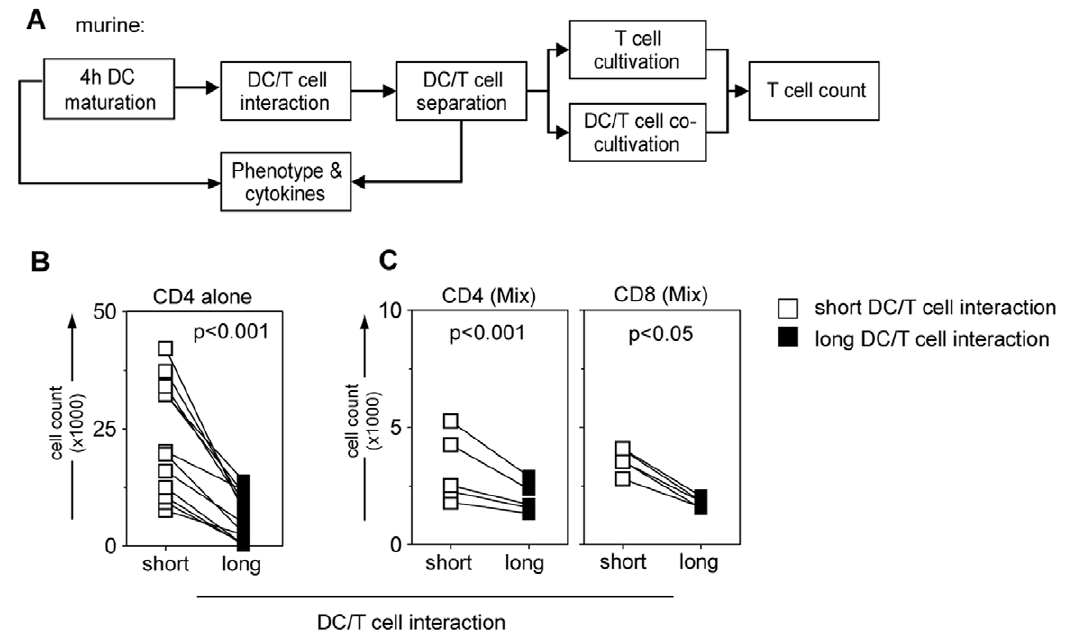
Figure 3. Proliferative capacity and polarization profile in short- versus long-term DC/T-cell co-cultures using murine BM-DC and T- cell receptor transgenic OT-I/II T-cells. (A) Murine BM-DCs were matured for 4 hours, contacted with naı¨ve syngeneic CD4 + enriched OT-II T-cells for 12 hours, separated using flow sorting, and either maintained alone in culture or re-cultivated with BM-DCs (further-on referred to as ‘‘short’’-term or ‘‘long’’-term DC/T-cell interaction, respectively), both for 3 days. (B) Total cell count of murine enriched CD4 + OT-II T-cells after 3 days DC/T-cell co- culture under short-term (white squares) or long-term (black squares) conditions with 4 hours LPS/IFN- c matured BM-DCs is shown. Pooled data from 12 experiments are shown as median 6 SEM. (C) A mixture of CD8 + OT-I and CD4 + OT-II T-cells was used (OT-I:OT-II=1:4) for short-term (white squares) or long-term (black squares) DC/T-cell co-culture, but analyzed on day 3 separately using specific staining for CD4 + or CD8 + molecules (middle and right graphs, respectively). Pooled data from 5 experiments is